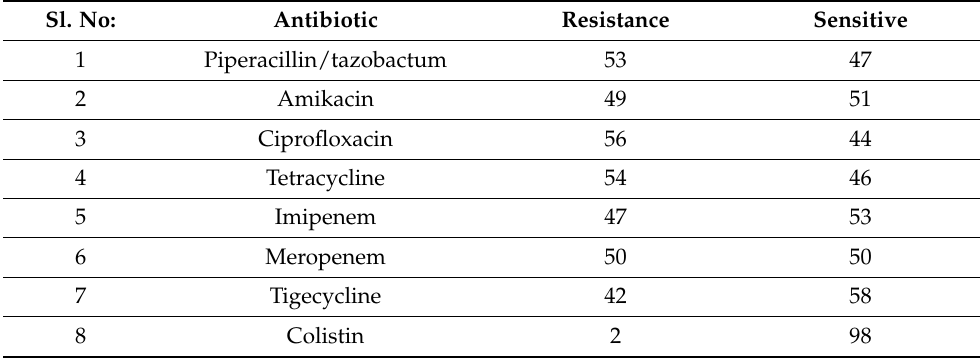
Table 1. Antimicrobial susceptibility profile of Acinetobacter isolates (n = 100). Sl. No: